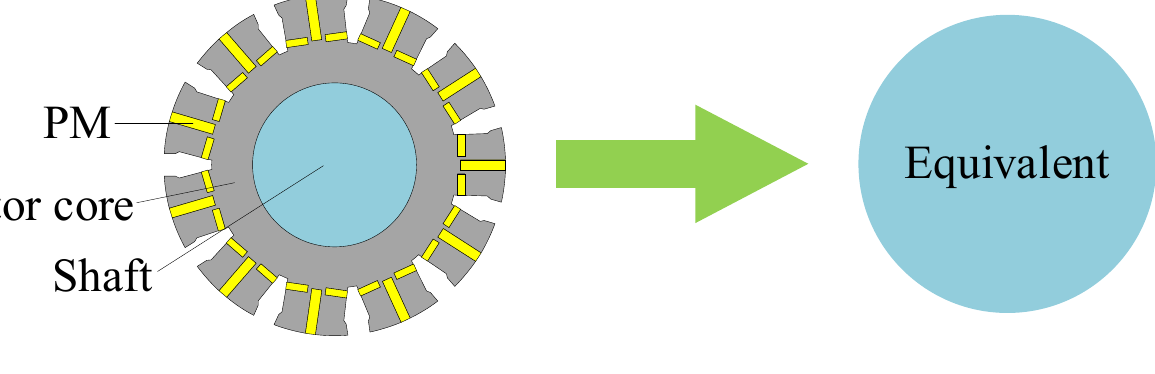
Figure 8. Equivalence of rotor.